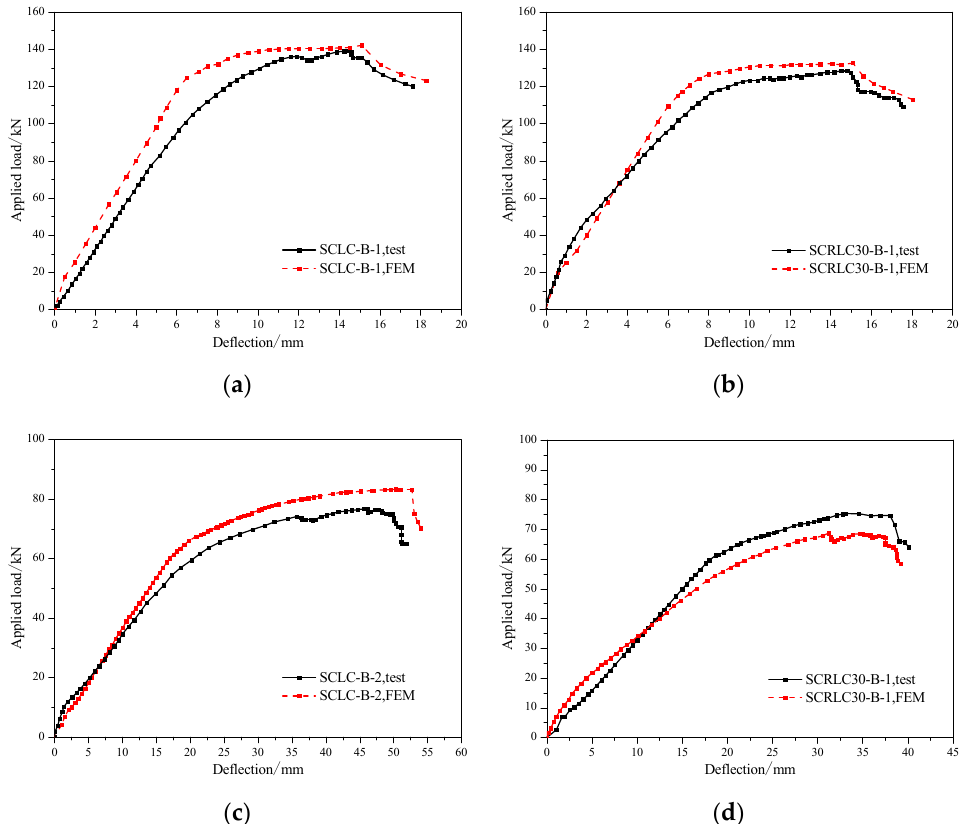
Figure 19. Comparison of load–deflection curves of composite slabs at mid-span between tests and